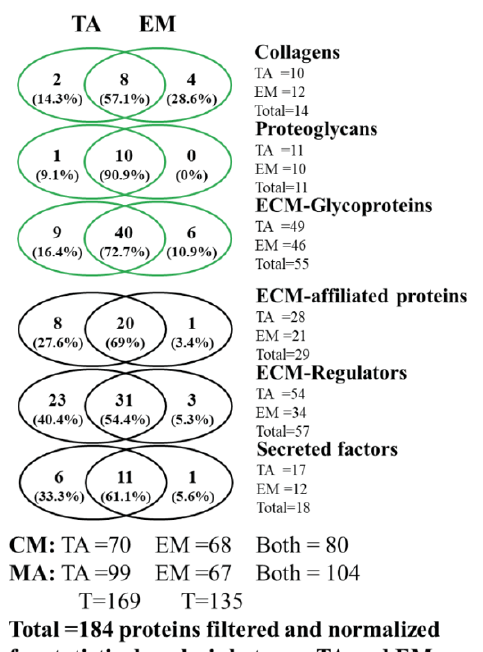
Figure 4. Mesenchymal enrichment of the antrum does not lead to notable ECM protein loss. Venn diagrams illustrating the overall BmpR1a △ FoxL1+ mouse gastric matrisome proteins identified using the two methods combined, indicating a wide overlap between the two approaches. Core matrisome proteins are presented in green and matrisome-associated proteins are shown in black. TA, total antrum; EM, enriched mesenchyme; CM, core matrisome; MA, matrisome-associated.